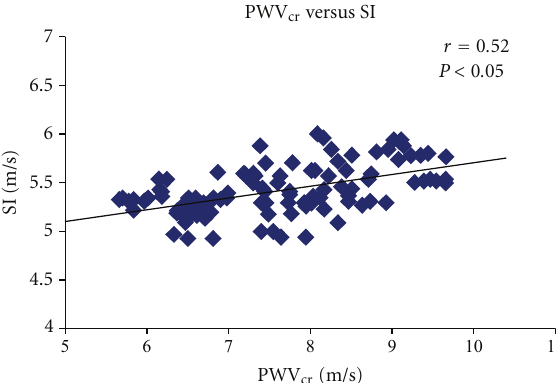
Figure 8: Relationship between SI and PWV cr during the whole experimental